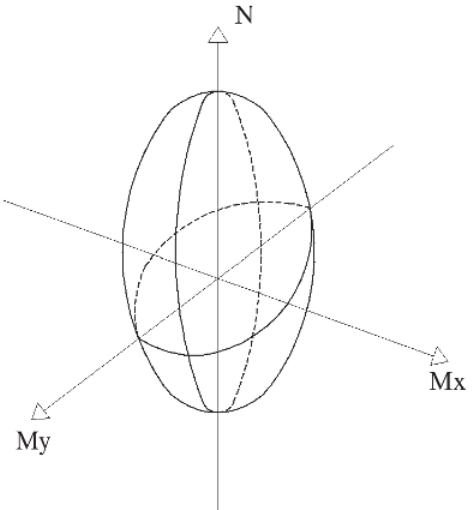
Superfície de interação entre esforço normal e momentos fletores